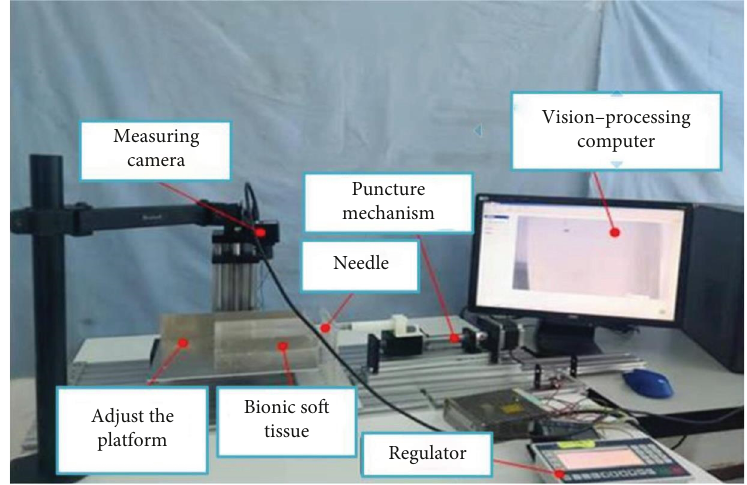
F IGURE 6: Puncture experiment